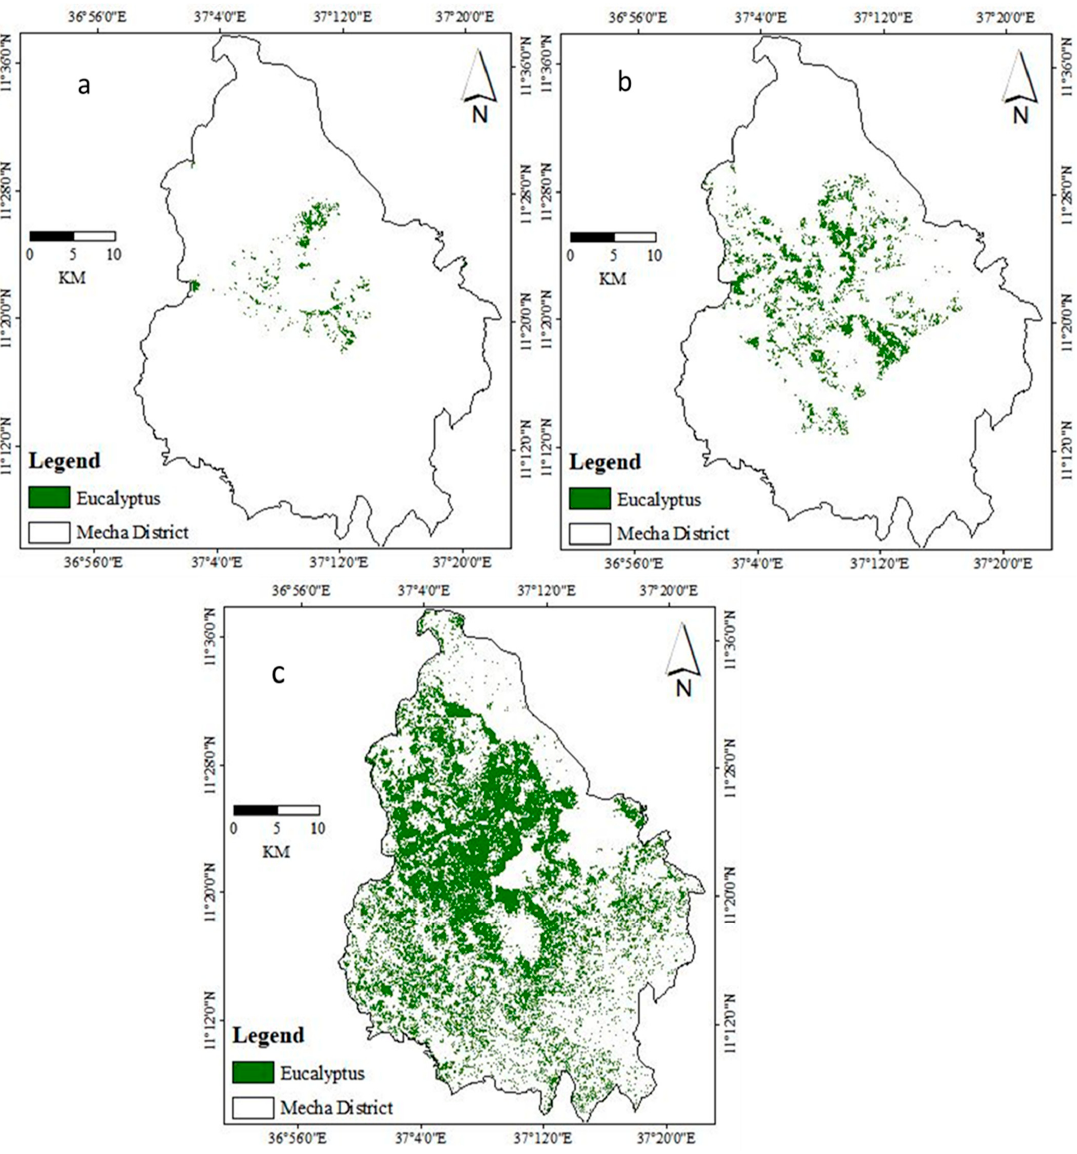
Figure 6. Spatial coverage of Eucalyptus plantation in the study area ( a ) 1991 ( b ) 2006 and ( c ) 2021. The result of remote sensing data proved that there was rapid expansion of Eucalyptus plantation during the past three decades in the Mecha district. The major factors for expansion of Eucalyptus plantation are the desirable price of the tree over food crops, fear for crop yield reduction due to adjacent Eucalyptus plantation, and low production cost (Table 5). Around 45.8% of respondent farmers prefer planting Eucalyptus on their plots, hoping to generates better income (Table 5). This finding agrees with the study by Zerga [48] indicating that recently Eucalyptus is becoming an immediate source of